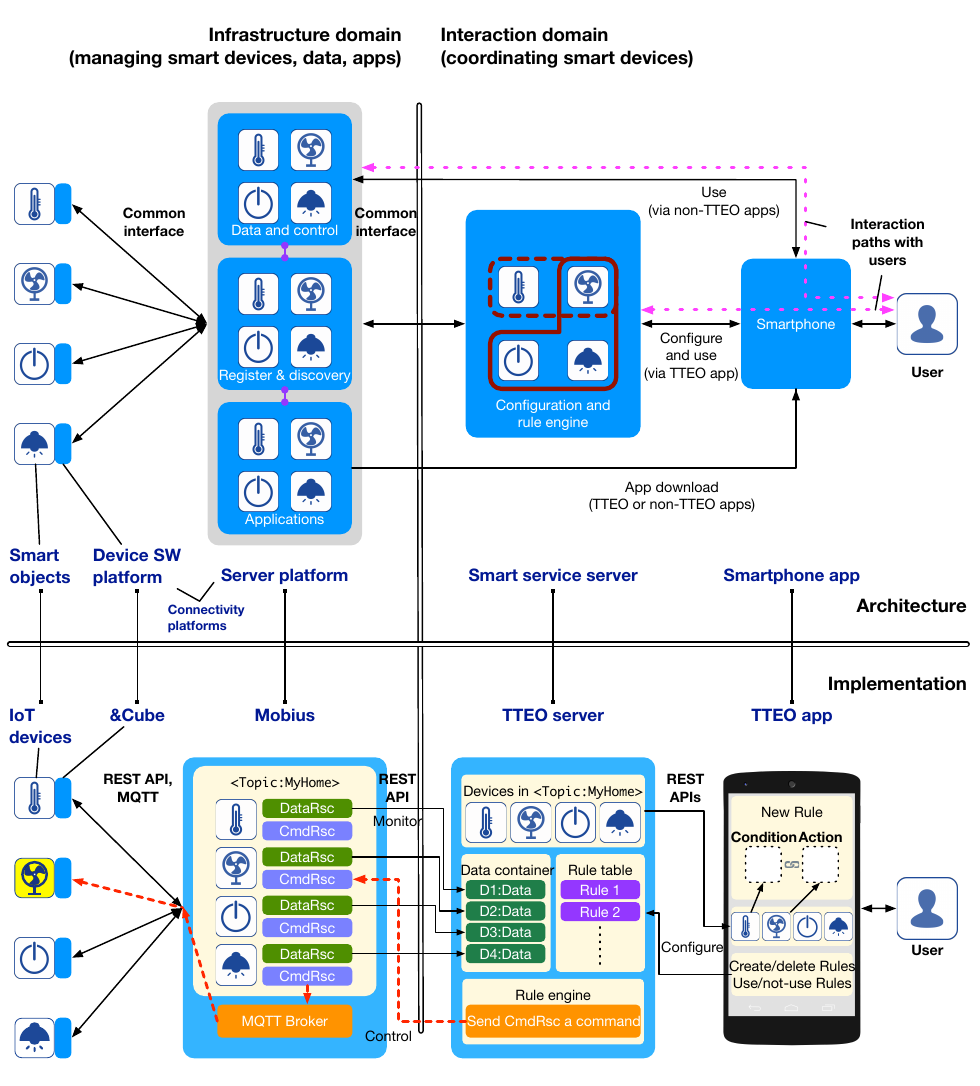
Figure 1. System architecture and implementation for IoT-based smart